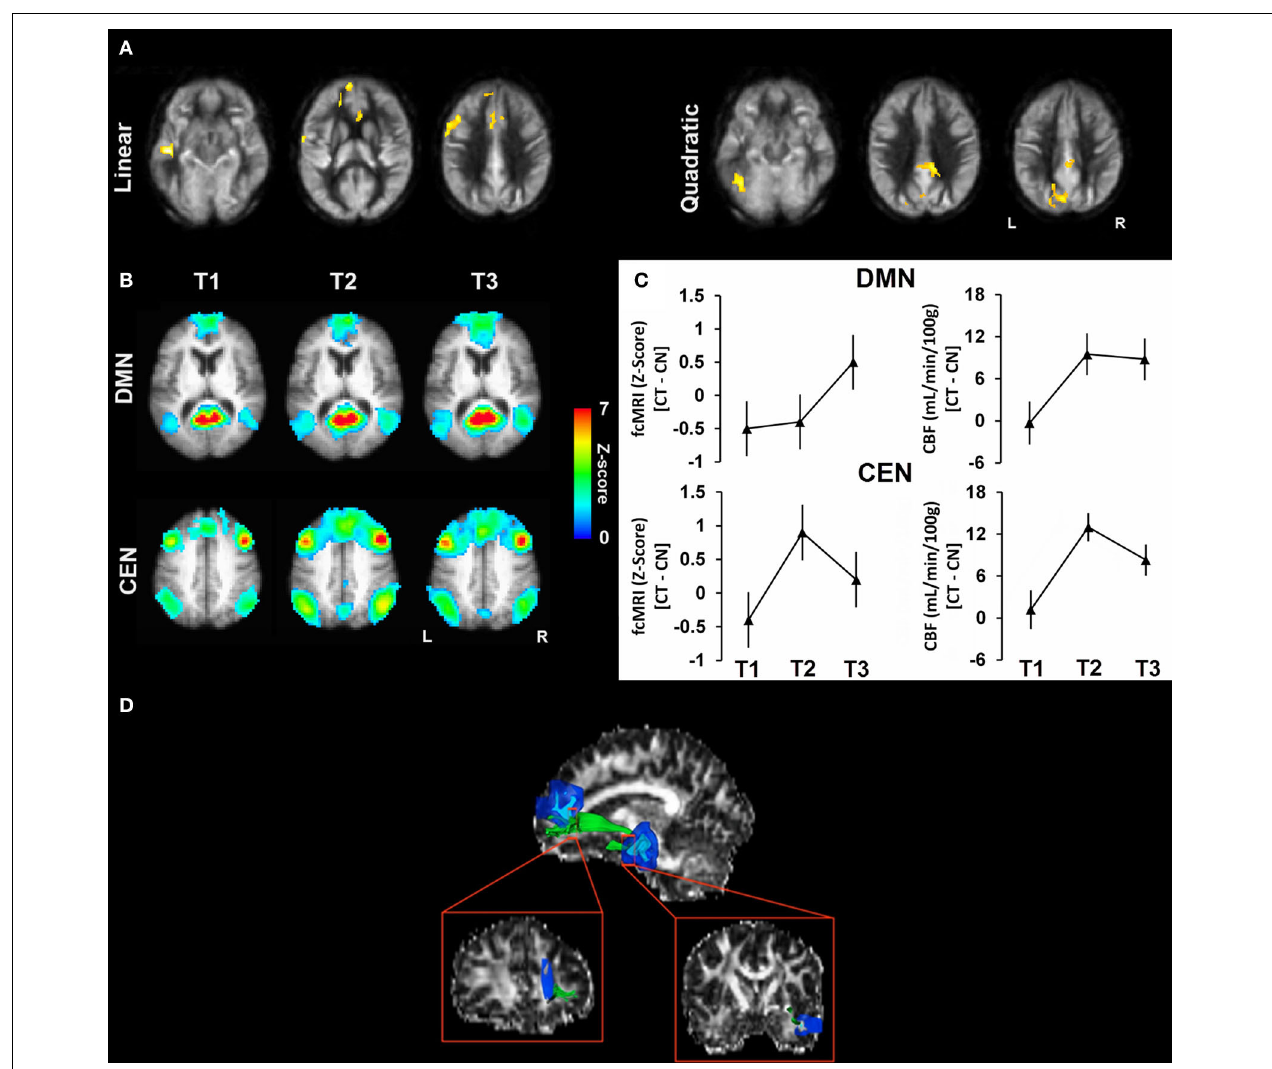
FIGURE 1 | This figure illustrates the convergence of neural plasticity findings in the cognitive training vs. control group across cerebral blood flow, functional connectivity, and structural DTI changes implicating functional brain changes more frequent and rapid than structural plasticity comparing changes at T2 and T3 to baseline T1 measures. (A) Results of CBF voxel-based comparison superimposed on an average CBF map of all participants for linear and quadratic interaction